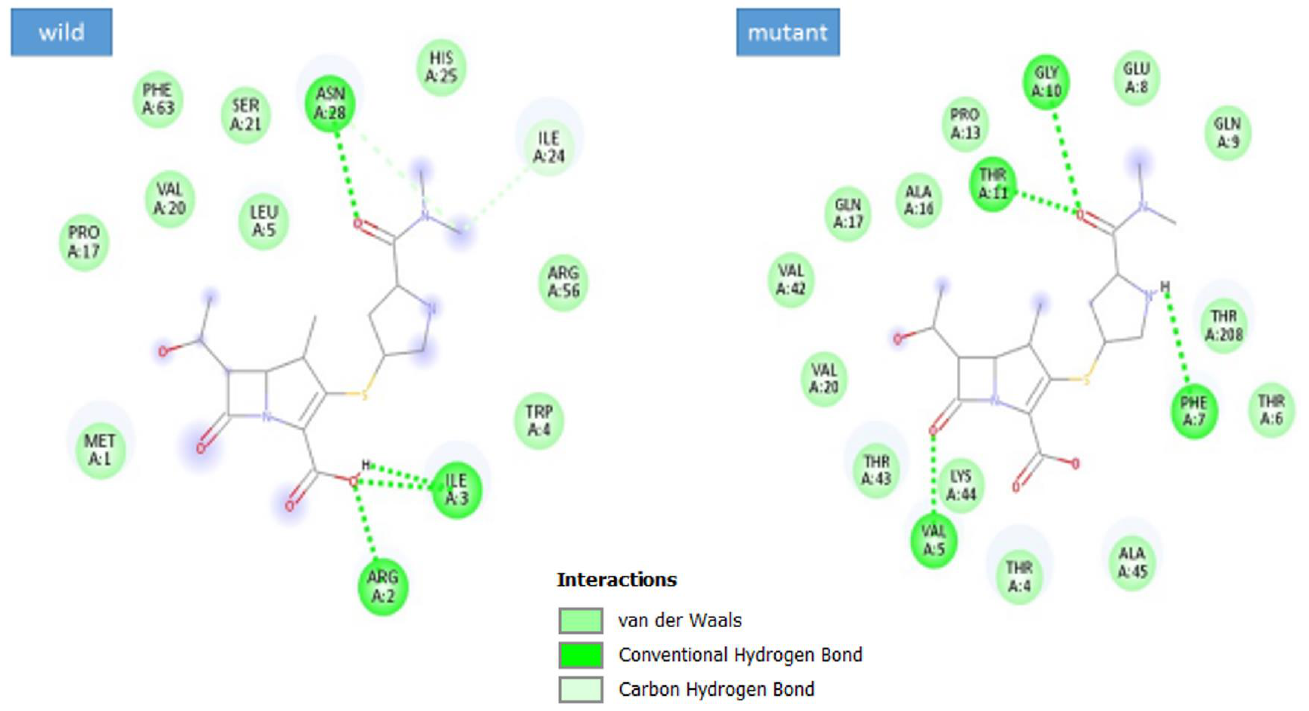
Figure 12. MexB wild and mutant binding interactions with meropenem. The compound is presented in a 2D line.